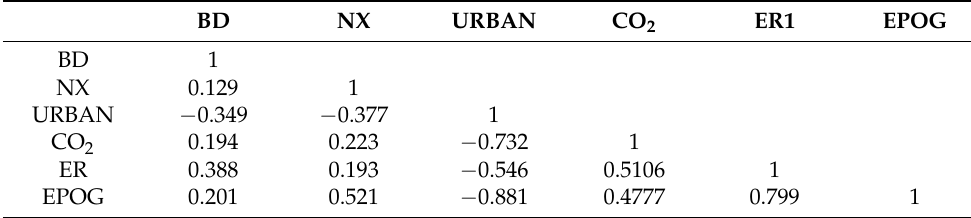
Table 3. Correlation coefficients between variables.